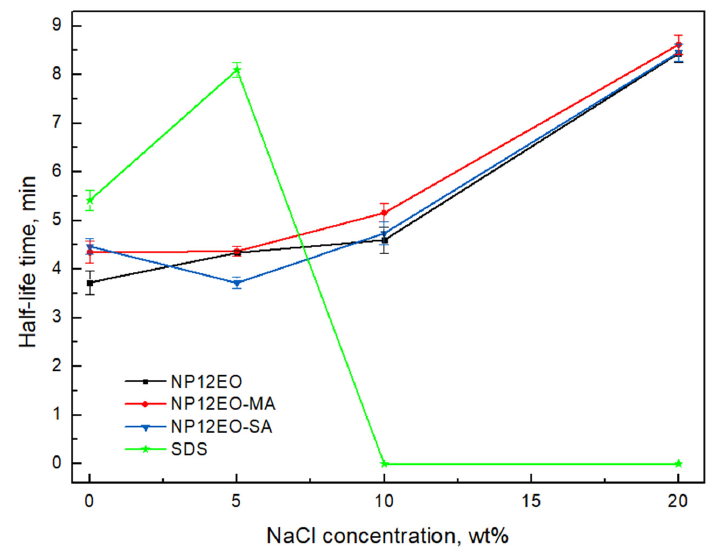
Figure 4. Foam half-life time at 0, 5, 10, and 20 wt% of NaCl concentrations.